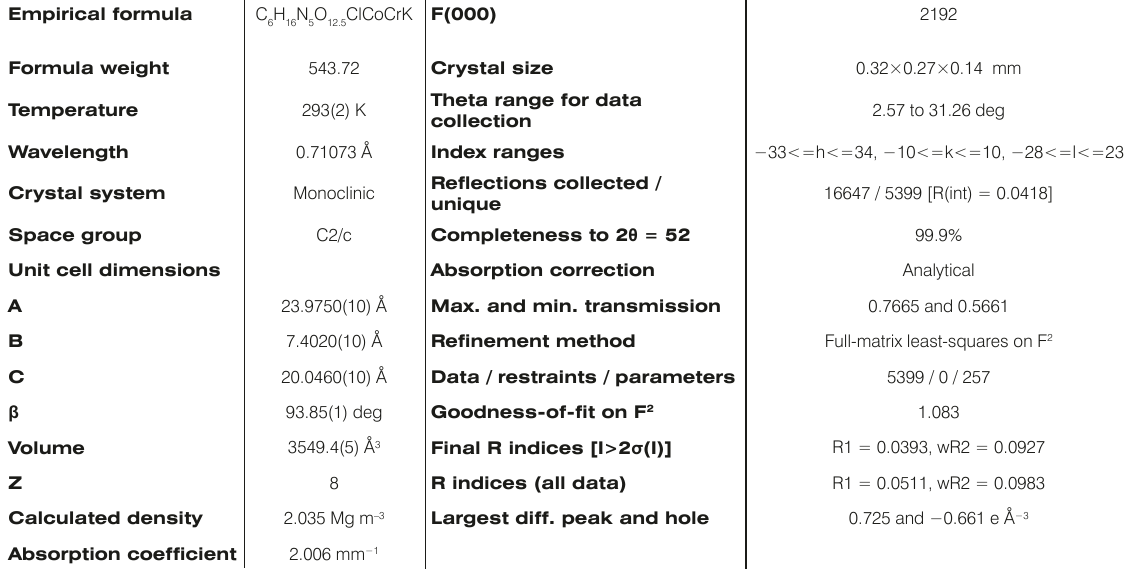
Table 1. Crystal data and structure refinement parameters for [CoCl(NH Empirical